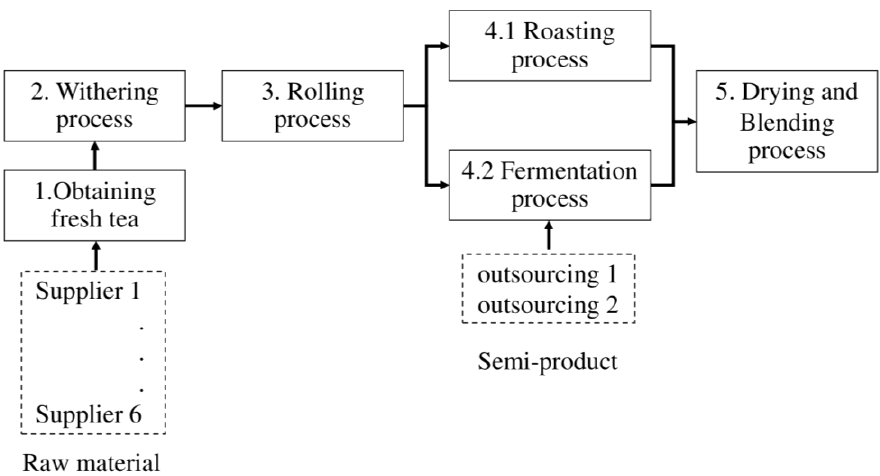
Figure 1. Flow process diagram of the tea blending factory. Table 2. Parameters of the case study.